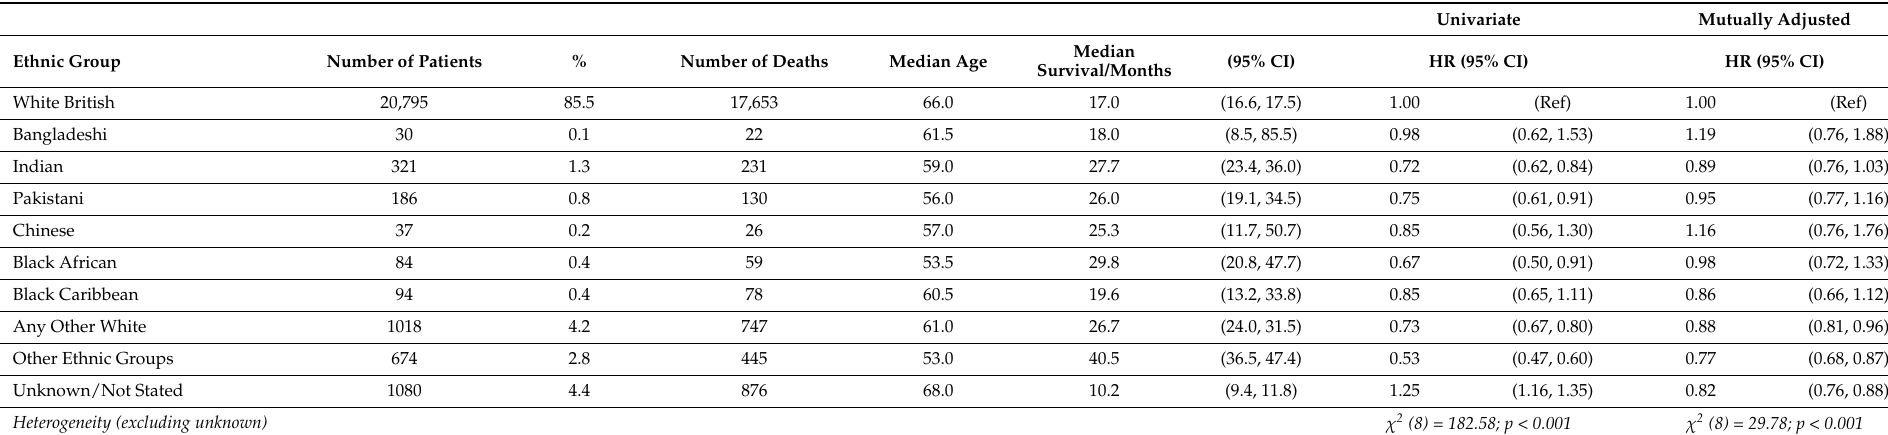
Table 2. Survival analysis of 24,319 patients diagnosed with malignant primary brain tumour in England, 2012–2017, by ethnicity.